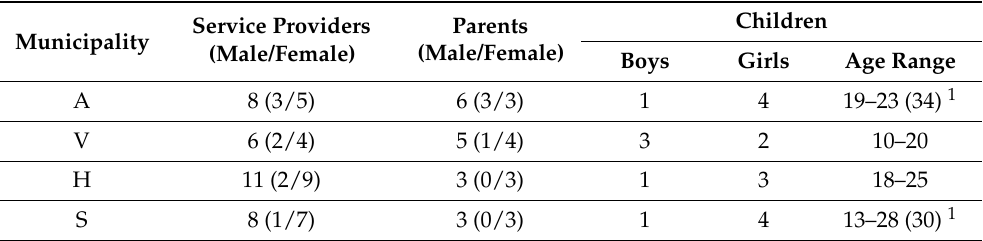
Table 1. Participants in Focus Group